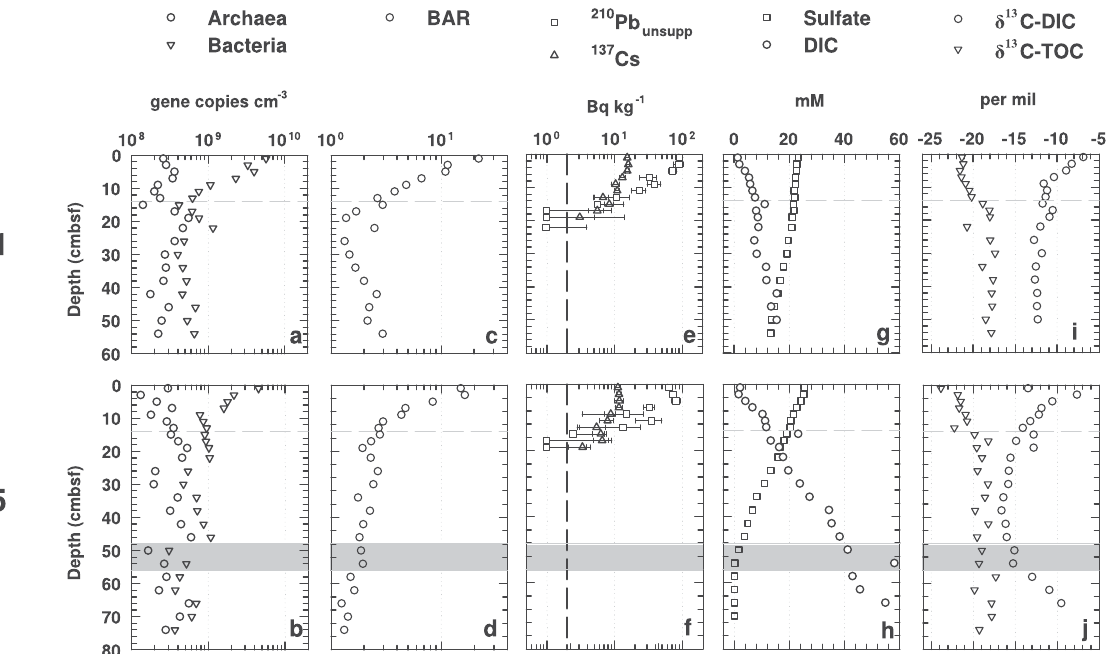
Figure 2. Fine-scale microbial abundance and geochemical profiles of surface sediments at M1 (M1-RL, top row of panels) and M5 (M5-RL, bottom row of panels). ( a,b ), abundances of archaeal and bacterial 16S genes; ( c,d ), BARs; ( e,f ) mean 210 Pb unsupp and 137 Cs values ± standard deviation (SD) - the detection limit of 210 Pb unsupp and 137 Cs is indicated by the dashed black line; ( g,h ), concentrations of sulfate and DIC; ( i,j ), δ 13 C-DIC and -TOC. The horizontal grey dashed lines indicate 0.14 mbsf, which is the minimum depth of macrofaunal sediment reworking based on 210 Pb unsupp . The shaded grey area at M5 marks the interval of the SMTZ.